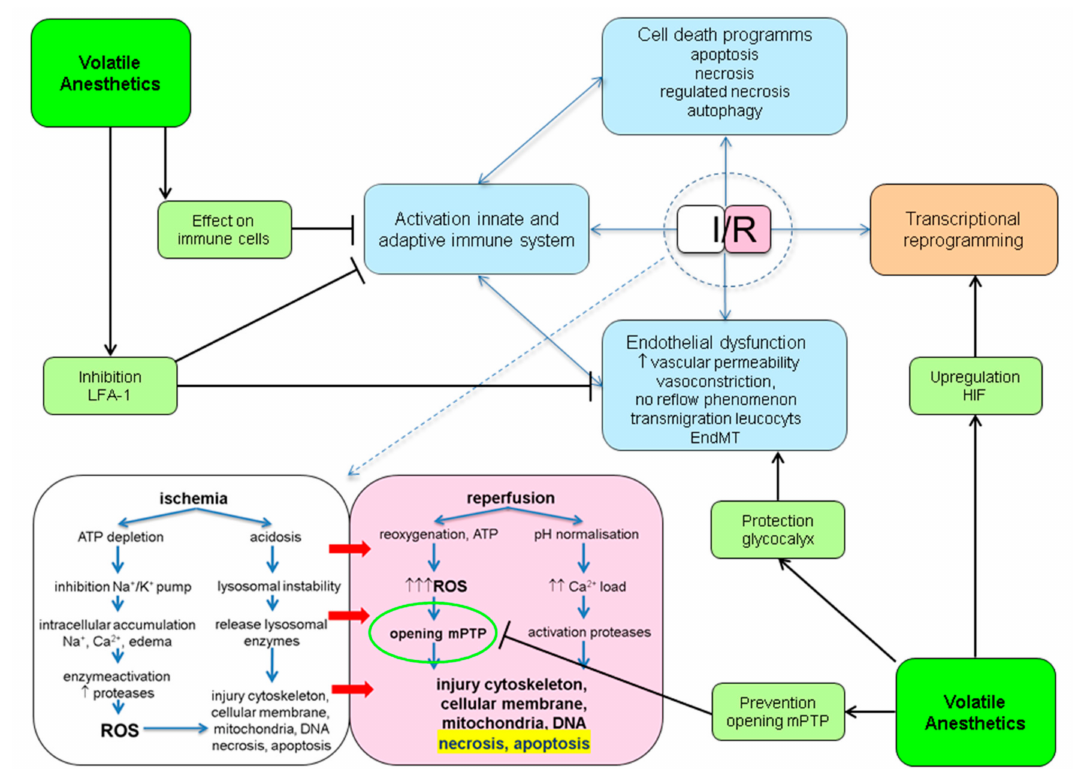
Figure 1. Potential protective points of engagement of volatile anesthetics (VA) in ischemia reperfusion injury (IRI). ATP: adenosine triphosphate; EndMT: endothelial to mesenchymal transition; HIF: hypoxic inducible factor; I/R: is- chemia/reperfusion; LFA-1: lymphocyte function antigen-1; mPTP: mitochondrial permeability transition pore; ROS: reactive oxygen